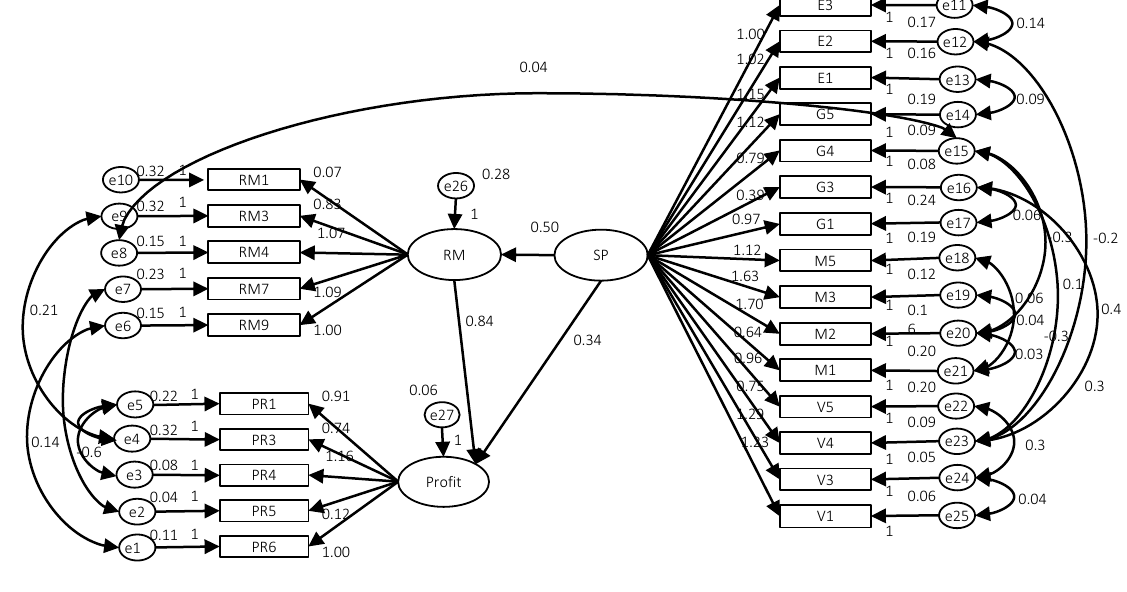
Figure 5. Mediation effect model